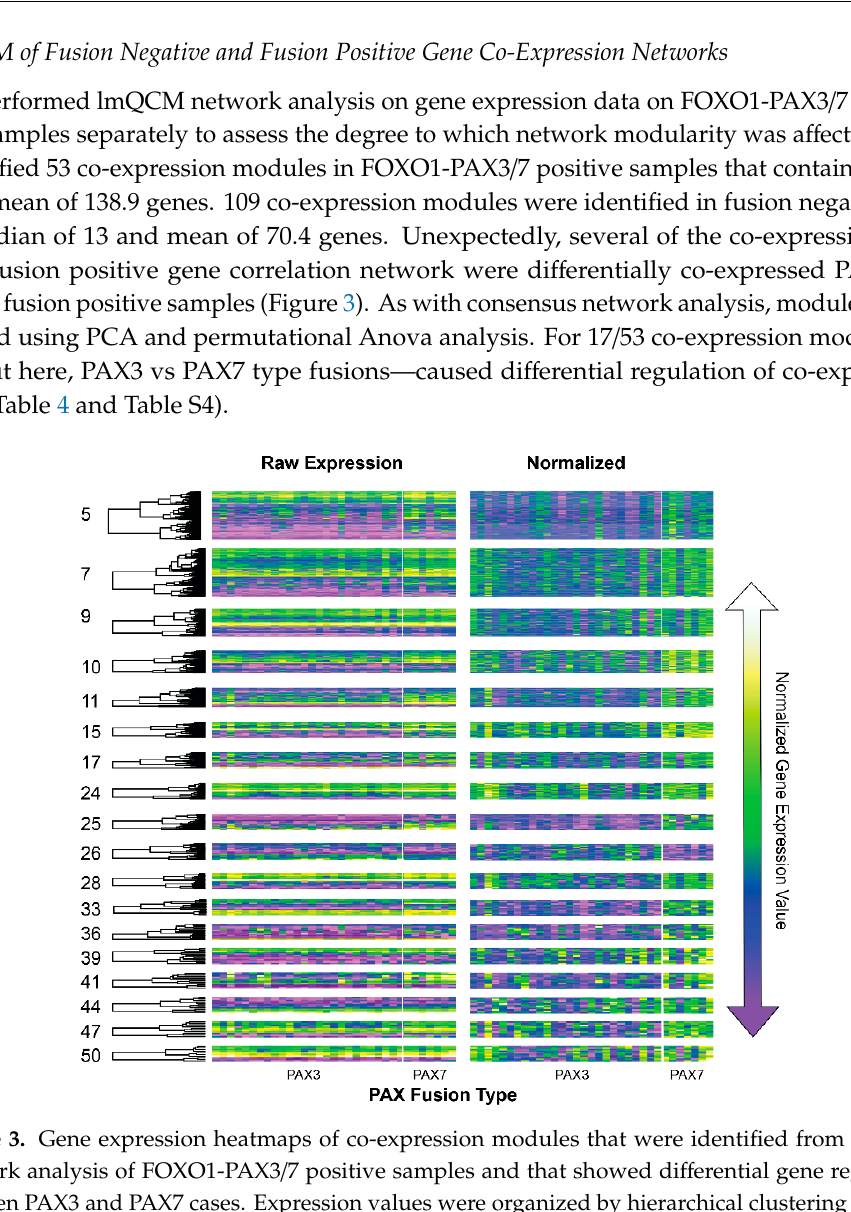
Table 3. Top results of ToppGene co-expression analysis for the 5 largest co-expressed modules identified by consensus lmQCM analysis (See Table S3 for more detailed table).